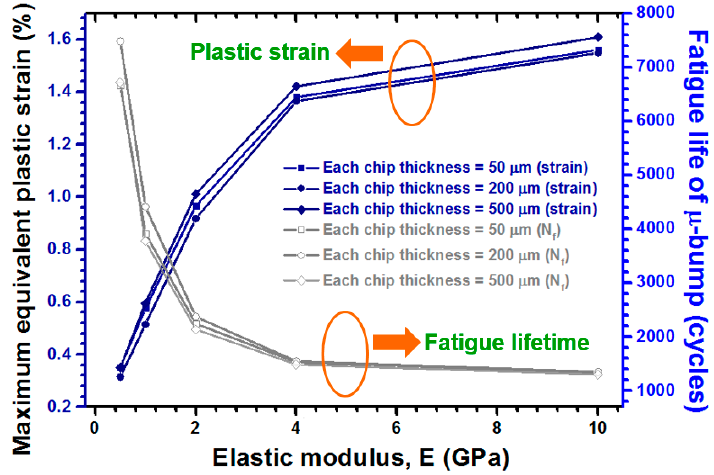
Figure 11. E of WLUF for maximum equivalent plastic strain and the corresponding estimated fatigue lifetime of the critical μ -bump in the first layer of stacked chips.